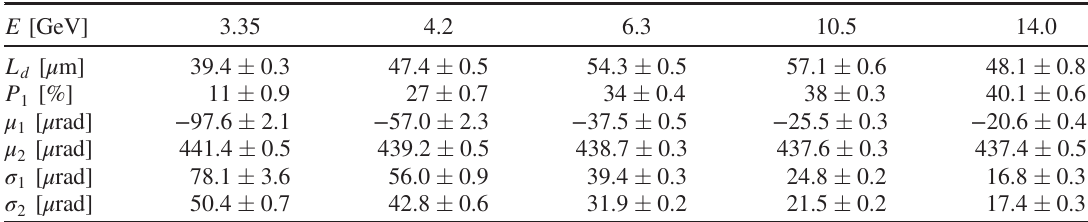
TABLE V. A table of the fitting parameters for the crystal DYNECHARM simulation in channeling orientation using the described model.